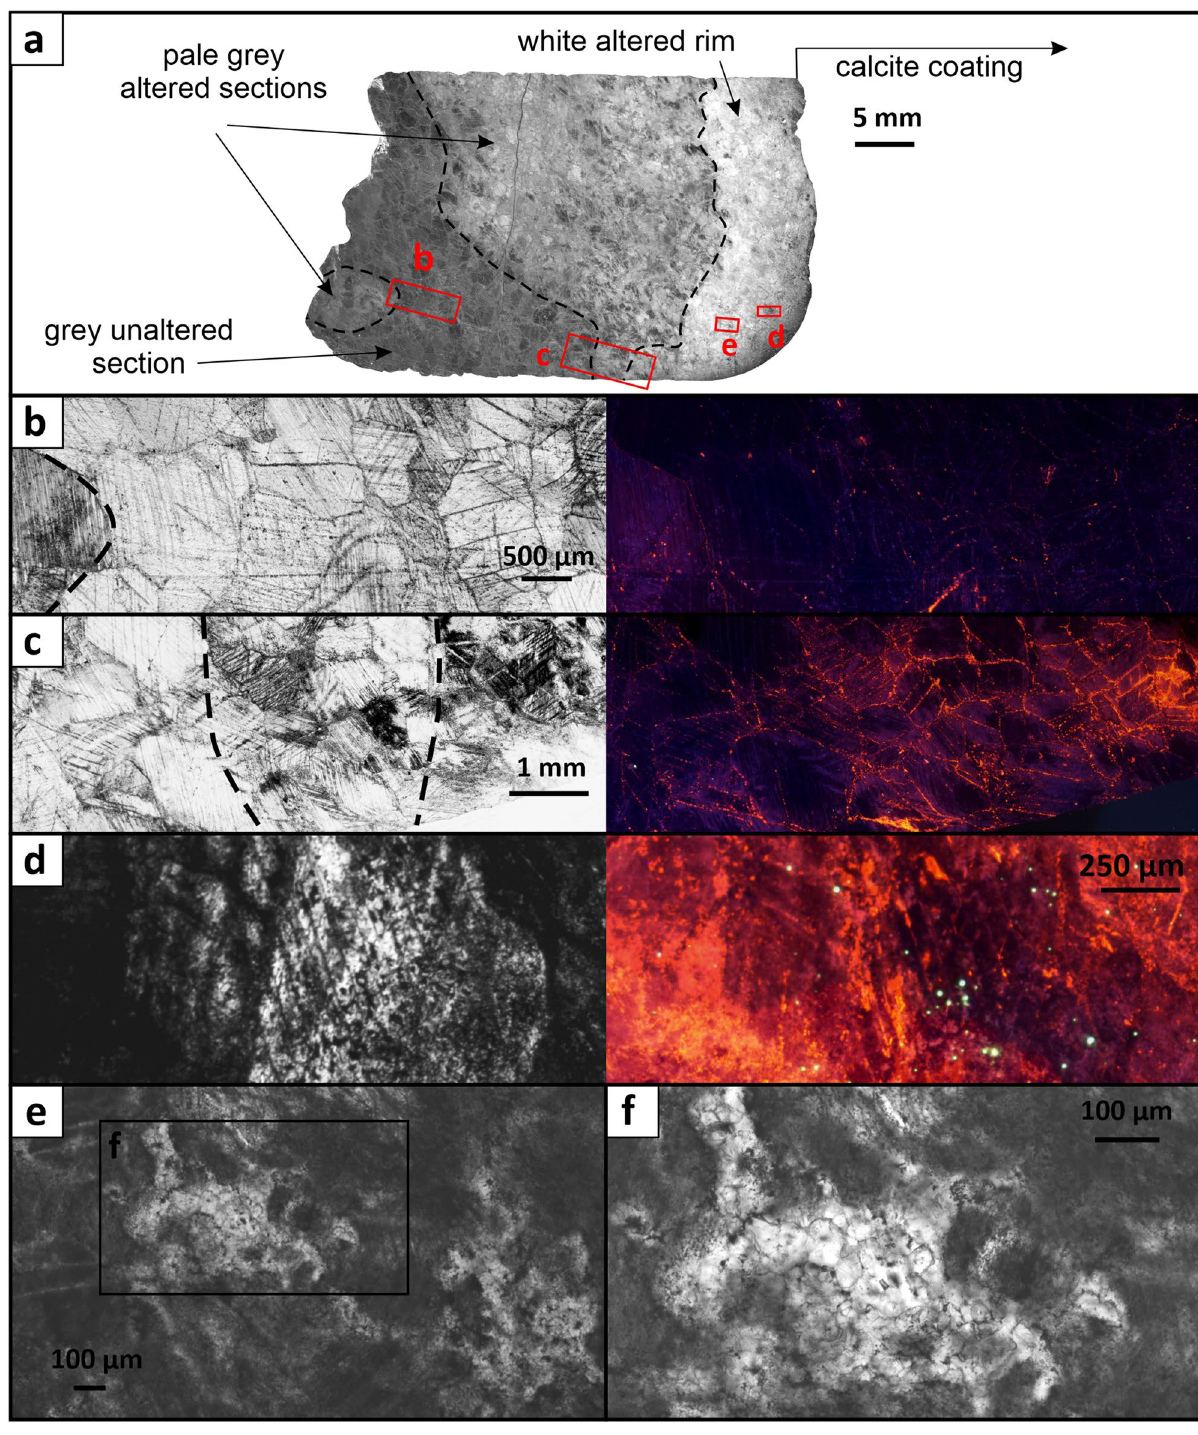
Figure 4. Photomicrographs of C2 core showing different sections of the calcite marble cave wall in plane- polarized transmitted and cathodoluminescent light. ( a ) Overview of the thin section from the outer part of the core with location of the closer examined sections. ( b ) View of the unaltered section of the marble having large (mm size) crystals with dark blue luminescence. ( c ) A cross-section from the unaltered (left) through pale grey (middle) to white rim section, showing dominantly dark blue, violet and orange luminescence, respectively. ( d ) Part of the white rim, with remnants of a large calcite crystal with dark blue luminescence that changes outwards to violet, surrounded by smaller crystals with orange luminescence. ( e , f ) Close-up view of the white altered rim section, showing very small calcite crystals filling up pore spaces. An extended version of this figure is found in Supplementary Fig.